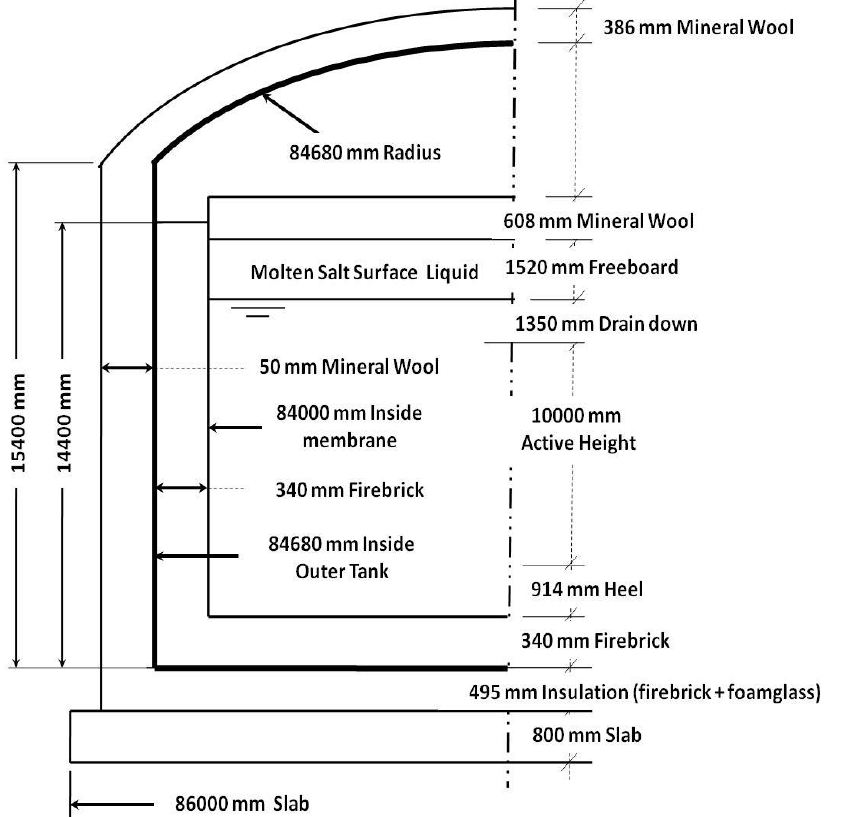
Fig. 10. Hot salt tank elevation